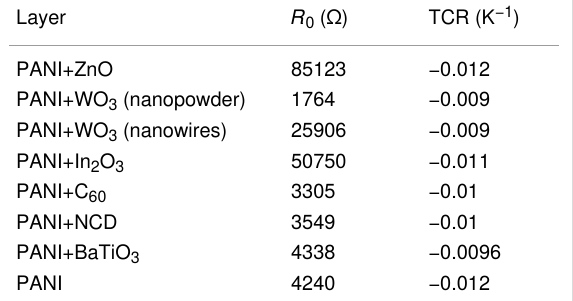
Table 1: Average TCRs of prepared sensitive layers in range from 20 to 80